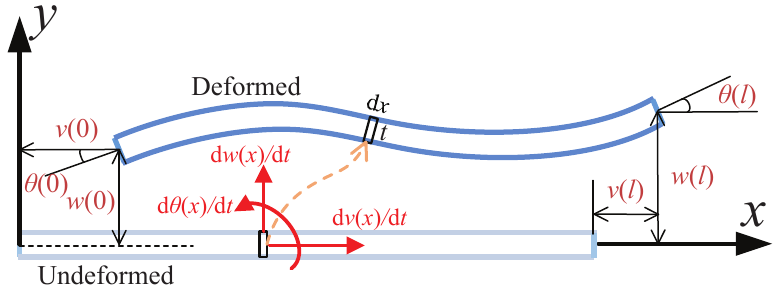
Figure 4. Schematic diagram of kinetic energy calculation for beam